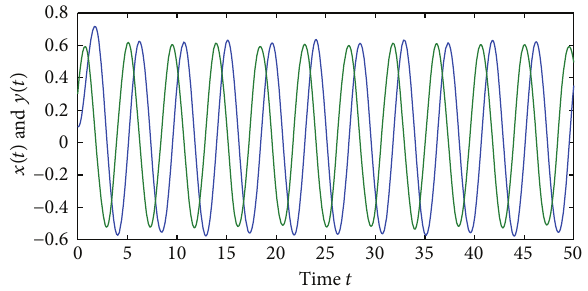
Figure 1: Almost periodicity of state variables 𝑥(𝑡) and 𝑦(𝑡) .